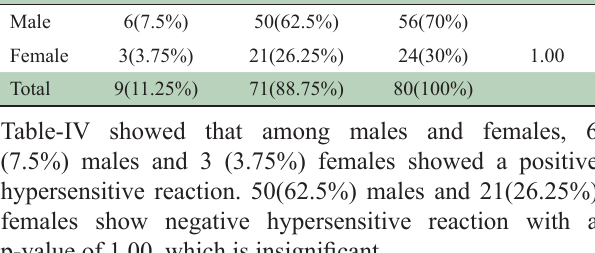
reaction when they were gone through a skin test, which contain 0.1 ml of piperacillin and